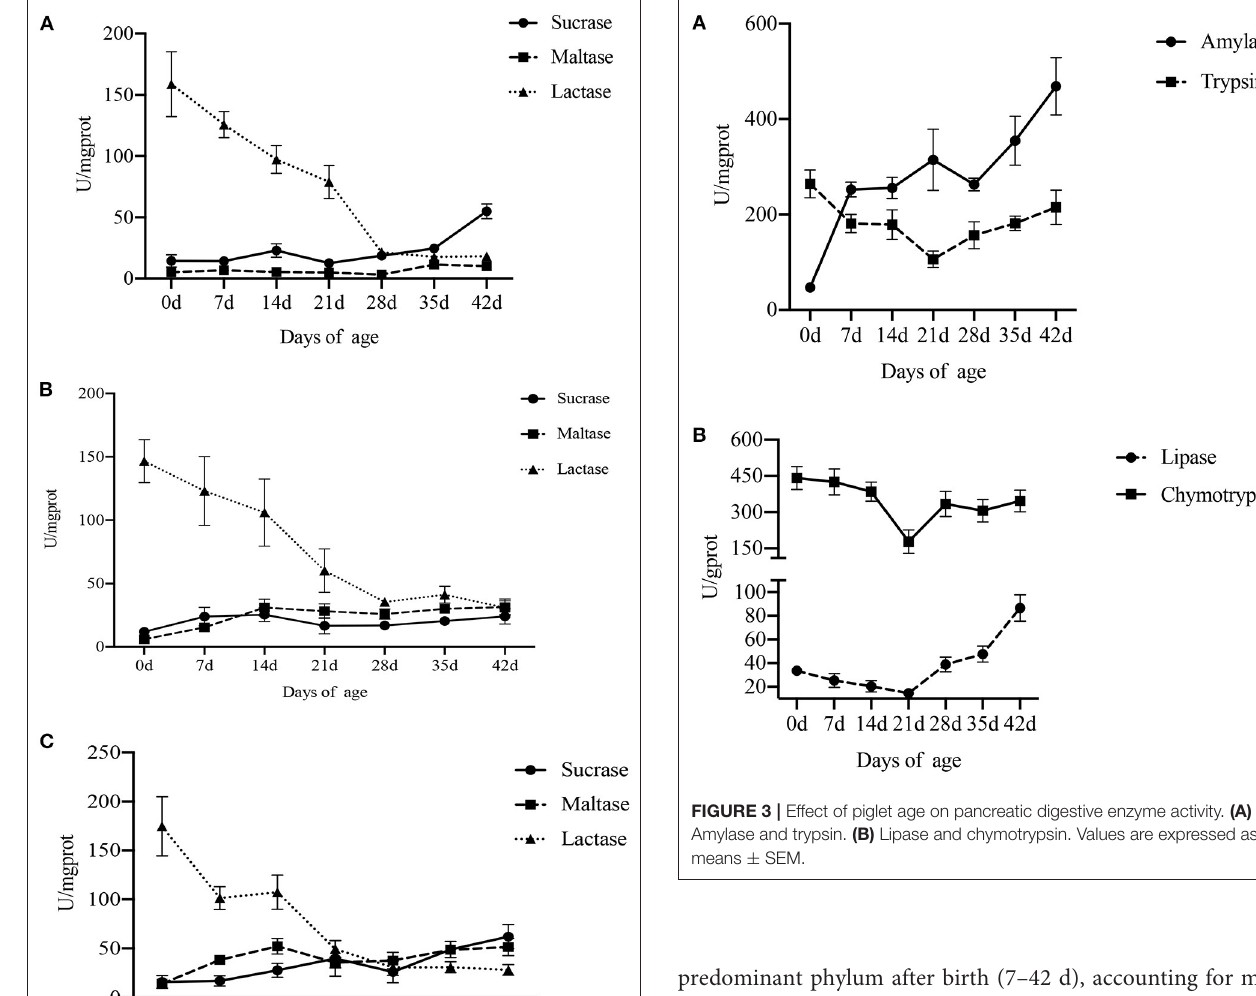
a relatively low degree of aggregation. Overall, these results suggested that the β -diversity of the colonic digesta microbiota of piglets increased with age.